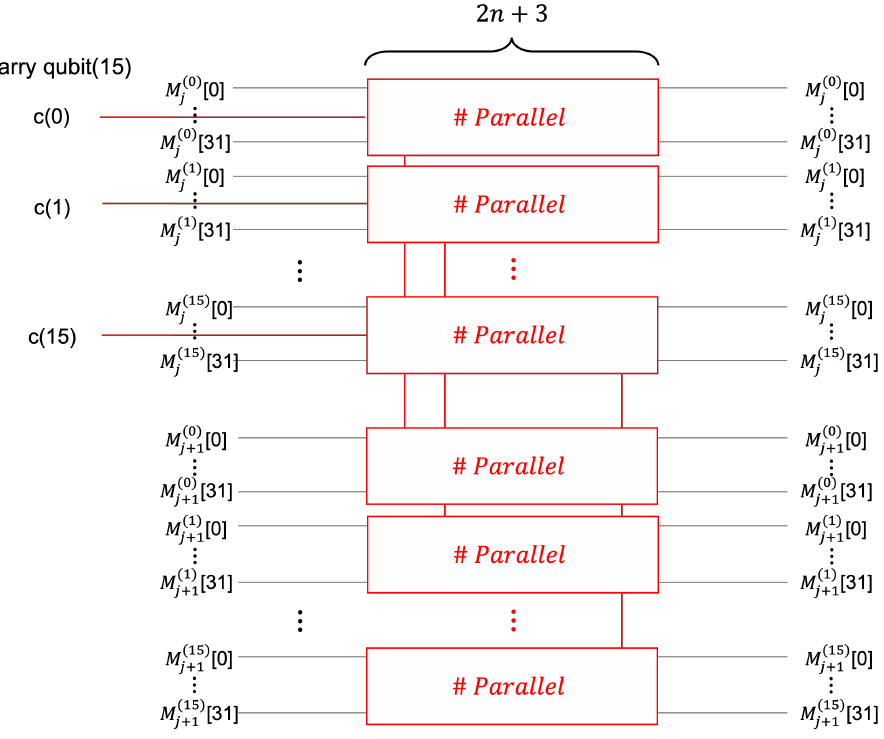
Figure 6. Parallel addition in MsgExp function. (Depth: only 2 n +